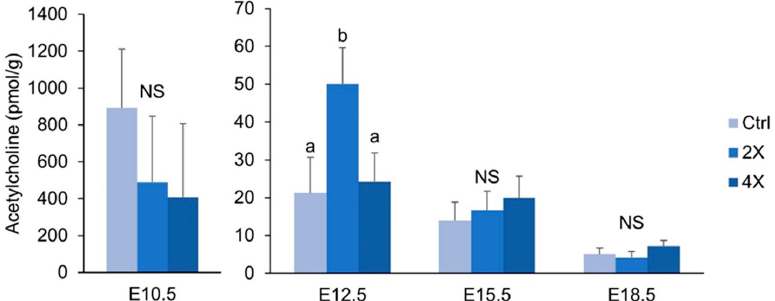
Figure 5. Placental acetylcholine concentrations (pmol/gram tissue) at E10.5, E12.5, 15.5, and 18.5 by maternal choline treatment (1X, 2X, and 4X choline). Data were analyzed using mixed linear models with choline treatment as a fixed effect and maternal ID as a random effect. Litter size, fetal genotype, and fetal sex were controlled for in the models as fixed effects. Values are presented as mean ± SEM. Different letters denote significant differences between means of the treatments at p ≤ 0.05. n = 20 placentas per treatment per time point. NS,